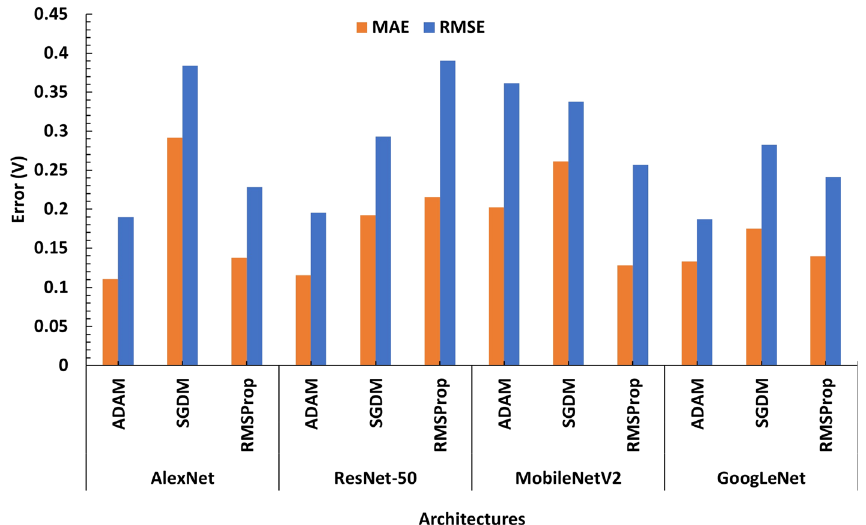
Figure 7. Model performance on yeast cells dataset for various architectures ResNet-50 with RMSPROP optimizer has the best validation RMSE of 0.0918 on test dataset, followed by the same ResNet-50 but with ADAM optimizer having a validation RMSE of 0.1241.